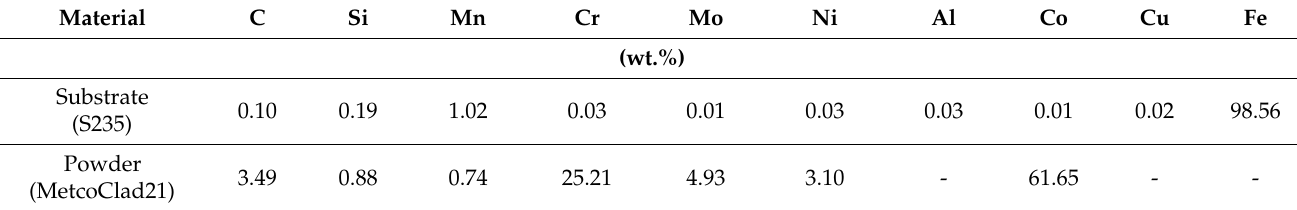
Table 2. Chemical composition of substrate material (S235) measured via optical emission spectrometry and powder material (MetcoClad21) measured via EDX.